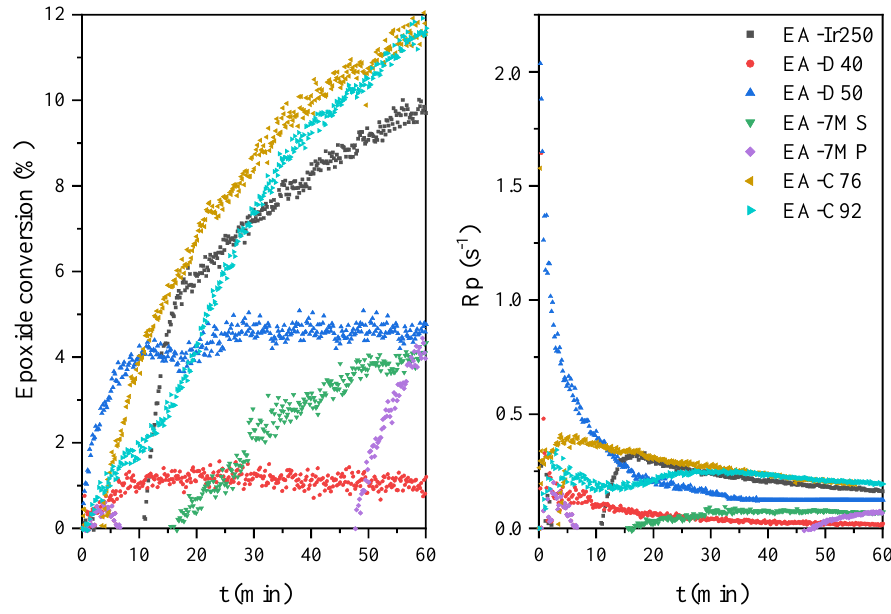
Figure 11. The epoxide conversion and photopolymerization rate curves of the epoxy acrylate formulations with cationic photoinitiators.